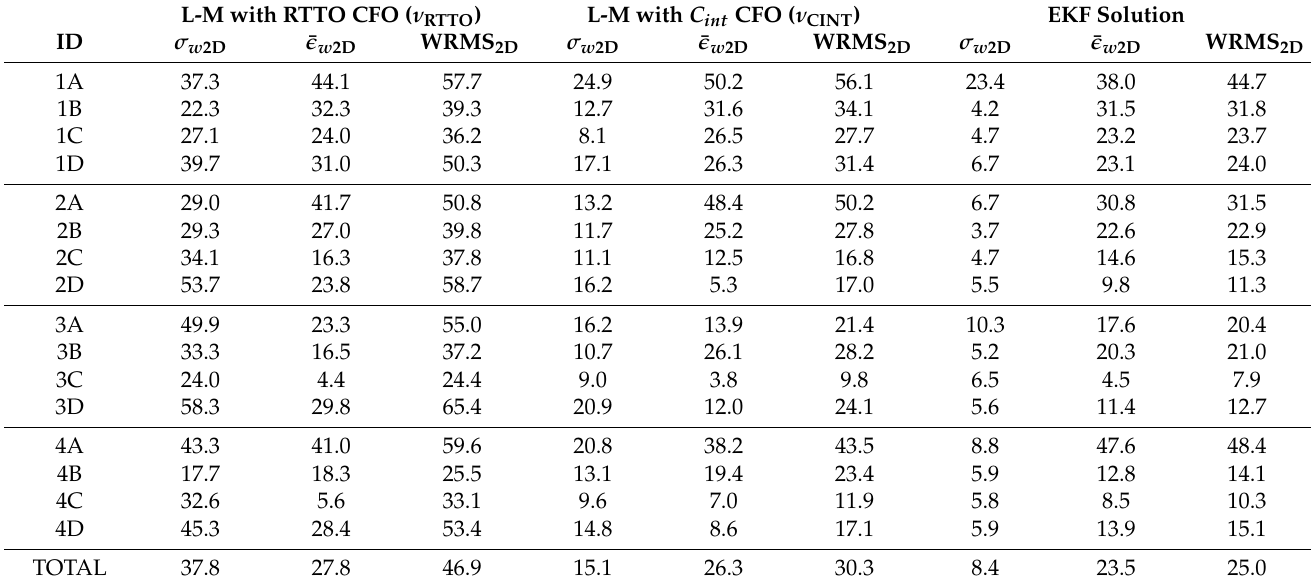
Table 4. Weighted statistics of 2D position estimates (all values in